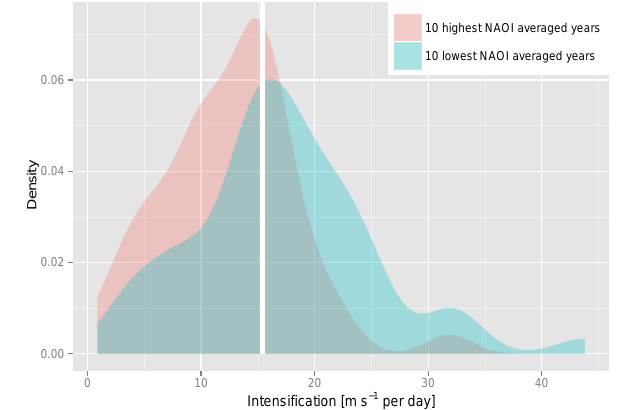
Figure 11. Density plot of five strongest mean intensification val- ues (scaled to 24h) for each of the 10 highest NAOI years (pink) and for the 10 lowest NAOI years (blue) in units of ms − 1 day − 1 (1ms − 1 day − 1 = 1.944ktday − 1 ). The white line is the RI thresh- old of 30ktday − 1